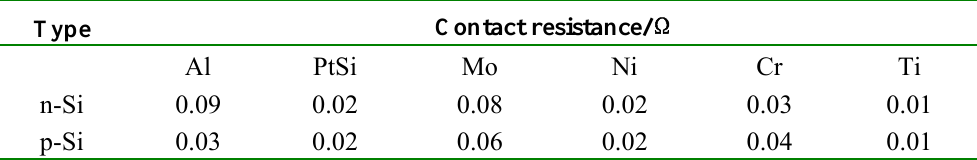
Table 2. Contact resistance between silicon and